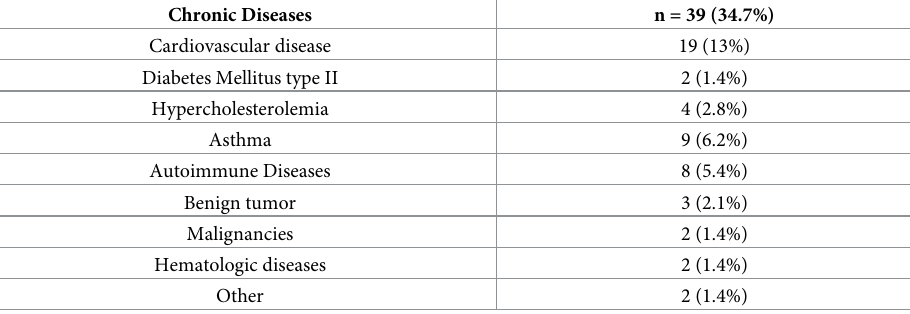
presented in Table 1 . Individuals were divided into three age groups: younger than 40 years old; 40–50 years old; and 50–65 years old. Body mass index (BMI) was calculated using each individual’s weight and height data. Based on BMI, the subjects were divided into two groups: Individuals with a BMI of less than 35 and overweight individuals with a BMI of 35 or more. Previous annual flu vaccination and pneumococcal vaccination in the last 1 year were also con- sidered. The medical history of the subjects included various chronic diseases, as presented in Table 2, classified into the following groups: cardiovascular disease (e.g., hypertension, coro- nary artery disease), diabetes, hypercholesterolemia, bronchial asthma, autoimmune diseases (e.g., Hashimoto’s thyroiditis, rheumatoid arthritis), benign tumors (e.g., pituitary adenoma), malignancies (e.g., breast cancer), hematologic diseases and others (e.g., migraines). None of the female participants was pregnant or lactating. Post-vaccination adverse events are pre- sented in Table 3 , classified into the following groups: local effects (e.g., pain or swelling at the vaccination site, limitation of hand movement), fatigue, arthralgias/ myalgias/ chills/ fever, headache, digestive system disorders (e.g., vomiting, diarrhea) and others (e.g., malaise). The study was in accordance with the Declaration of Helsinki and International Conference for harmonization for good clinical practice and was approved by the Scientific and Ethics Com- mittee of “Saint Savvas” Oncology Hospital of Athens (Ref No. 186/448-140-701/07-01-2021). All subjects gave written informed consent, which was signed before participating in the study. Subject data were kept confidential in accordance with the rules of the General Data Protection Regulation. Table 2. Chronic or other diseases of individuals included in the